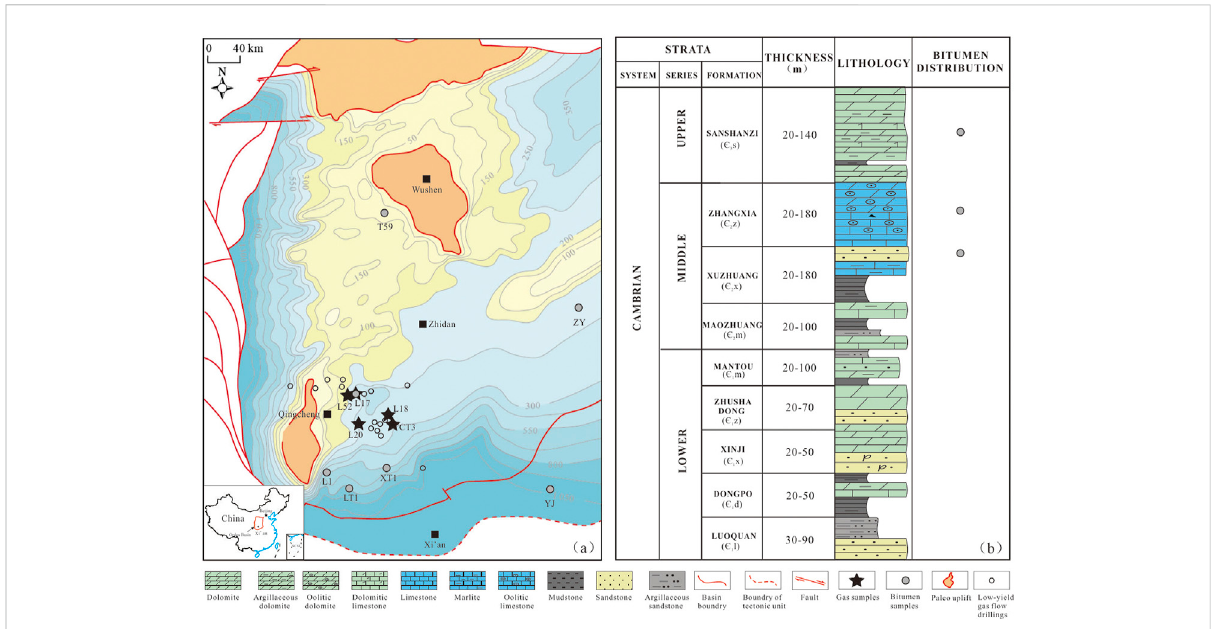
FIGURE 1 Thickness of Cambrian strata and sampling locations (A) and comprehensive stratigraphic column; (B) of the Cambrian at the southern part of the Ordos